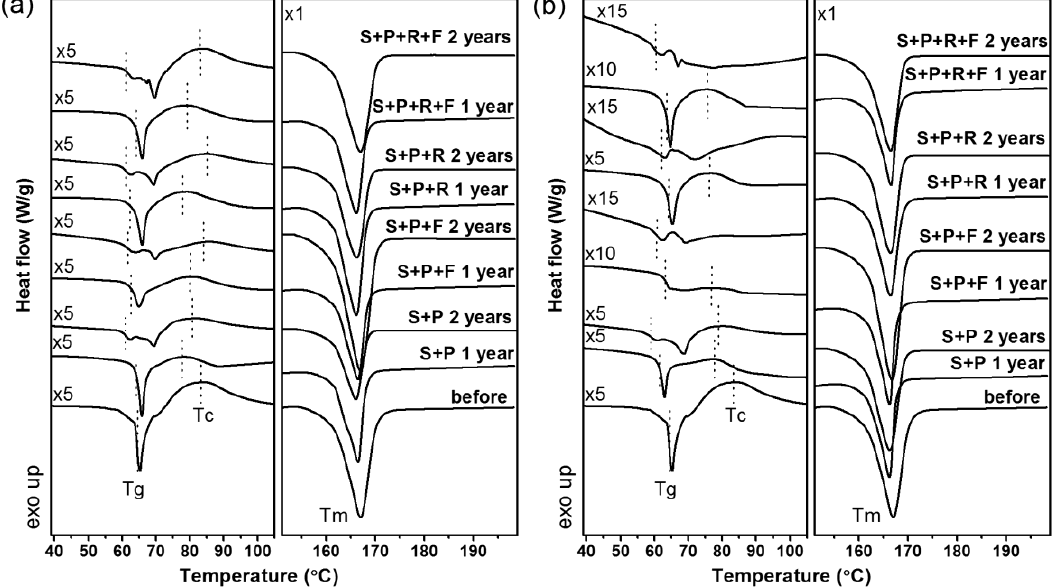
Figure 3. DSC thermographs of PLA spun-bonded mulching nonwovens recorded before and after composting in ( a ) Cracow and ( b ) Plovdiv.